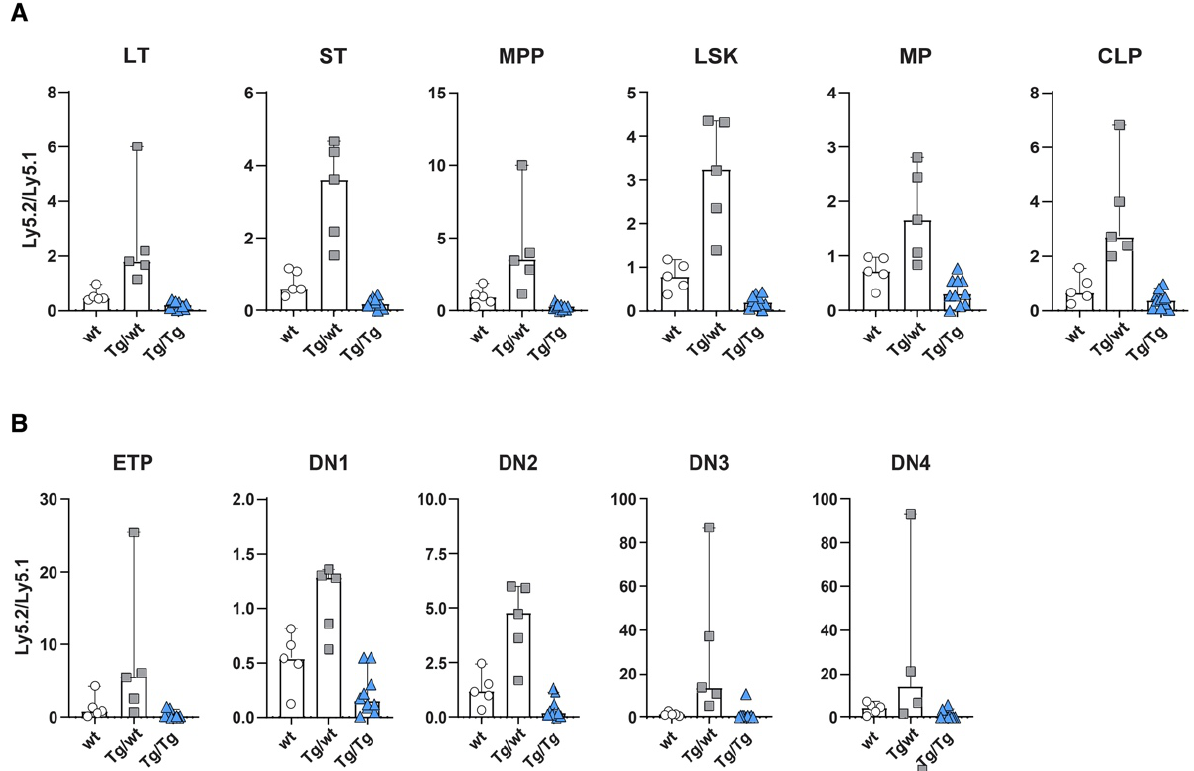
Figure 3. Wnt signaling dosage model alters HSC function and early T cell development. Repopulation efficiency analyzed in the bone marrow ( A ) and thymuses ( B ) of mice transplanted with Ly5.2 wild-type (wt), heterozygous Axin2-mTurquoise2 (Tg/wt), homozygous Axin2-mTurquoise2